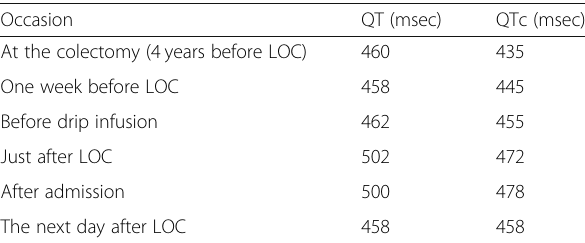
Table 2 QT and QTc intervals on electrocardiogram before and after onset of loss of consciousness (LOC)